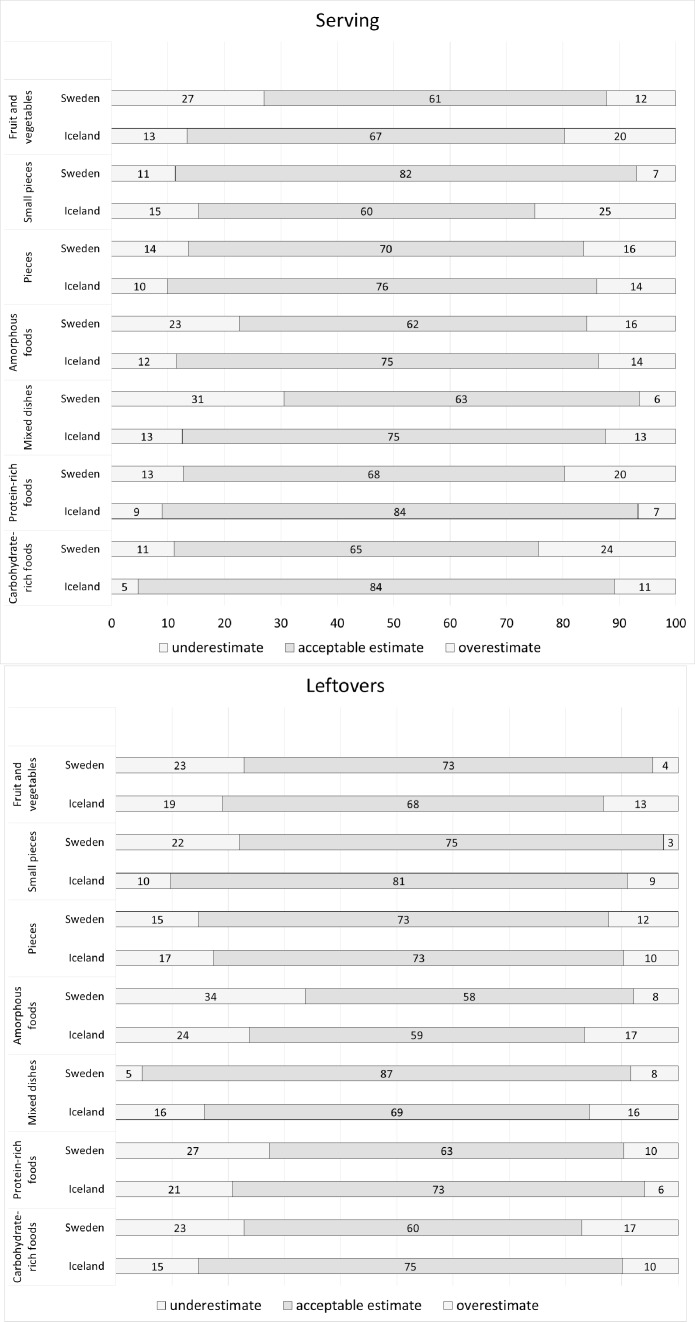
Agreement of photo method with weighted portions by country and type of foods (%).Dark part of column represents the proportion of acceptable estimates, with lighter part of column showing under- and overestimate respectively. a) Serving, b) Leftovers. Estimation of all food items/groups was significantly different (p<0.05) between the countries except for leftovers of pieces (p = 0.175).